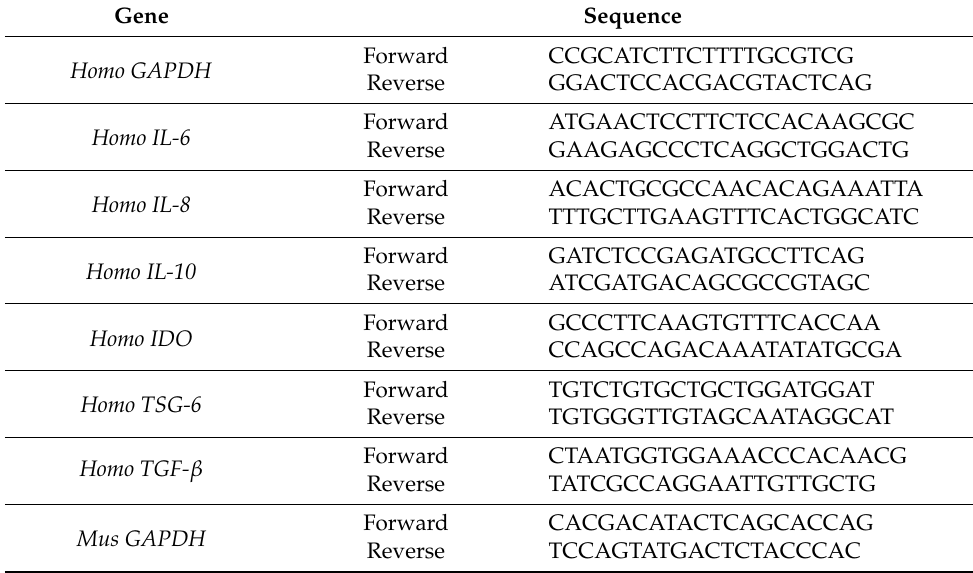
Table 1. Primer sequences for